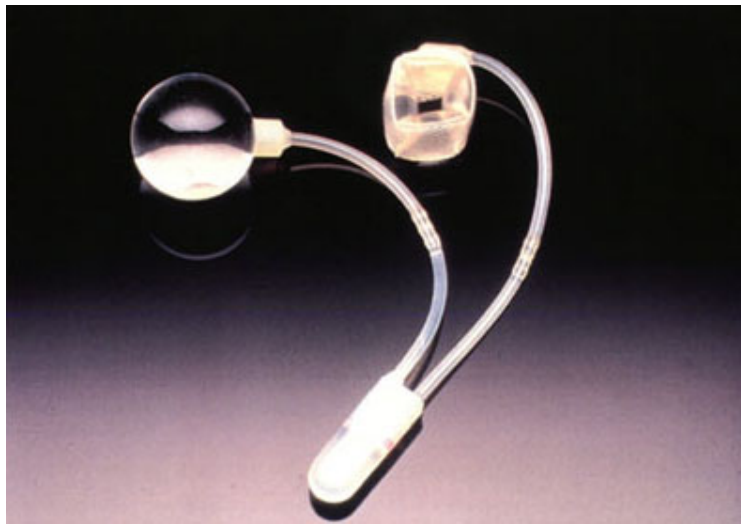
FIGURE 5. AS-800 artificial urinary